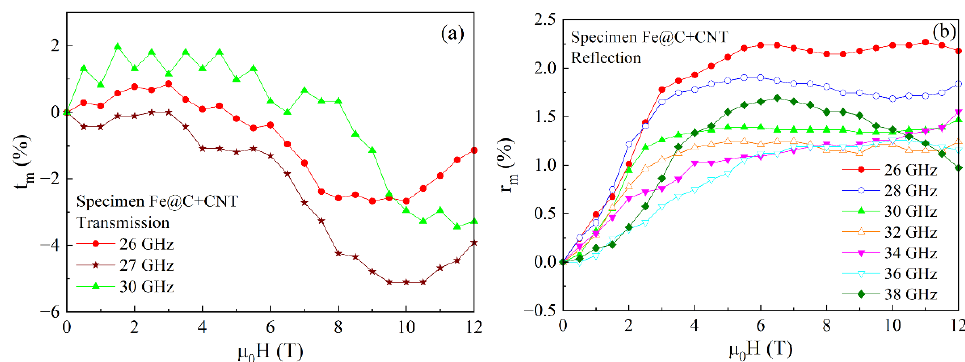
Figure 10. Magnetic field dependences of the transmission ( a ) and reflection ( b ) coefficients, measured at several frequencies of the millimeter waveband for the sample of 10 mm thick with Fe@C particles and CNT.